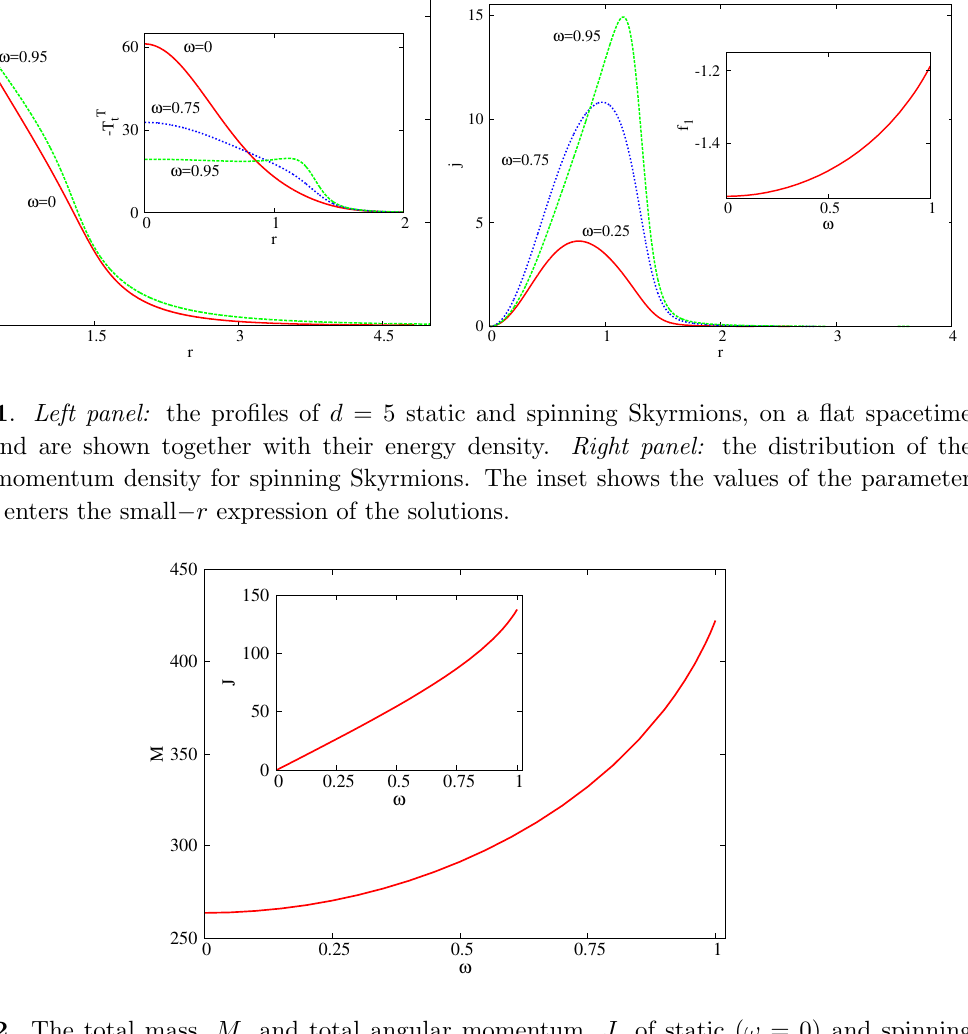
Figure 2 . The total mass, M , and total angular momentum, J , of static ( ! = 0) and spinning Skyrmions on a (cid:13)at spacetime background are shown as a function of their frequency !